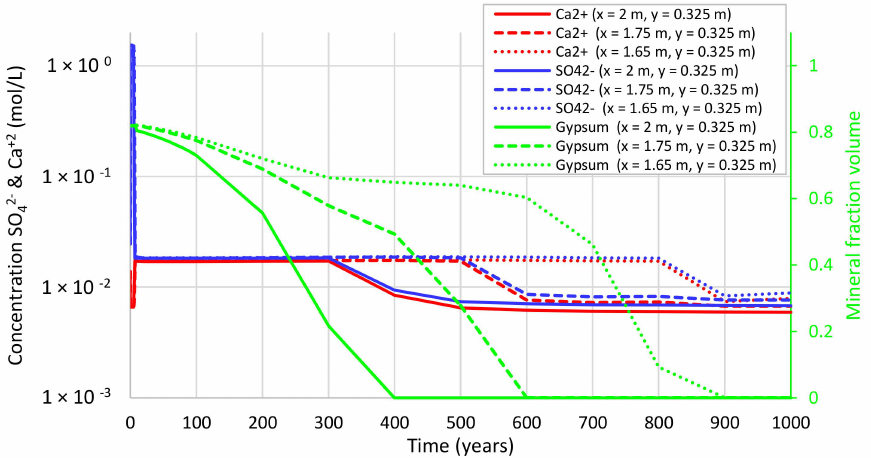
Figure 7. Time evolution of the computed concentrations of dissolved Ca 2+ and SO 42 − and the volume fraction of gypsum at three selected nodes at the bottom right of the model domain at coordinates (1.65, 0.325), (1.75, 0.325), and (2.0, 0.325) in scenario 1.